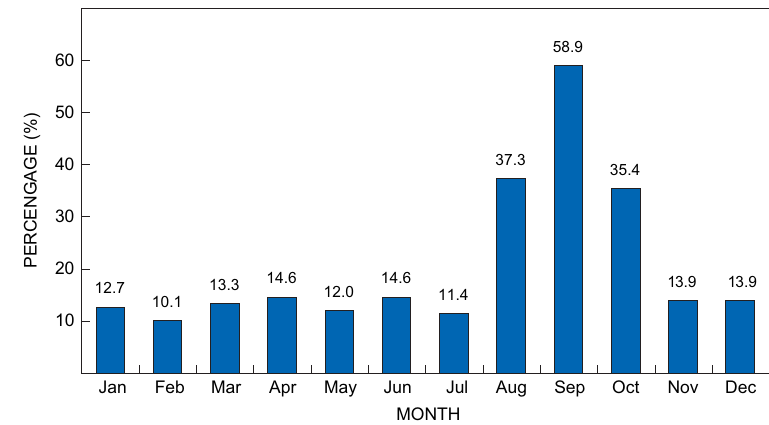
Figure 1: Months reported by students as being when their allergic rhinitis symptoms are worst ( n =